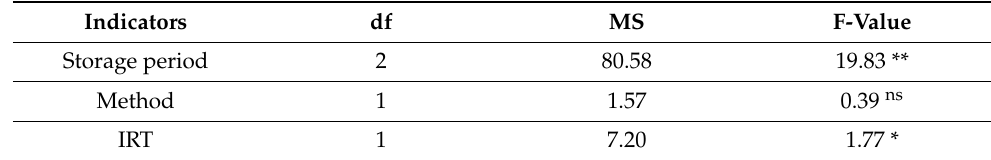
Table 5. ANOVA of the effects of the storage period (months), method, and infrared radiation treatment (IRT) on GABA content.